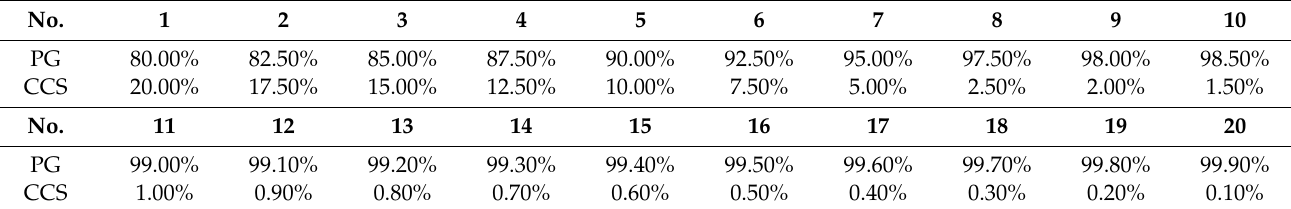
Table 1. Different ratios of CCS and PG.